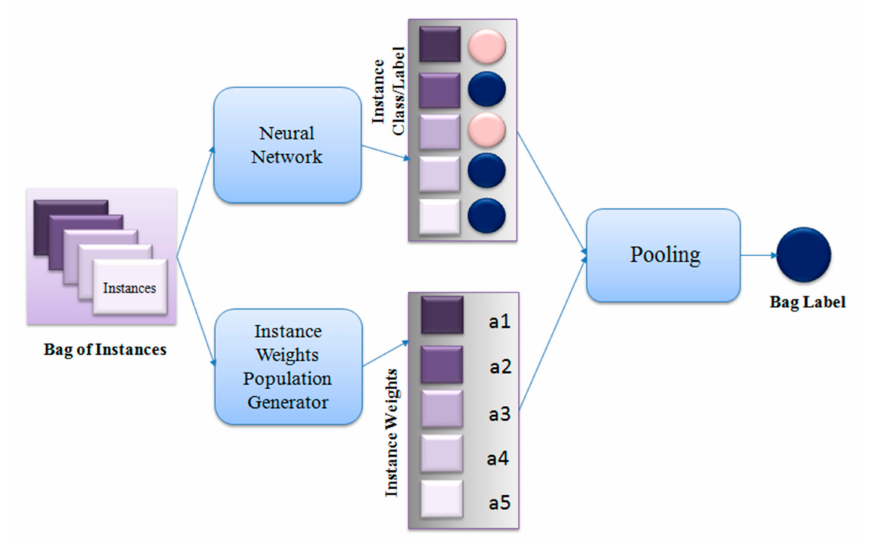
Figure 4. Evolutionary pooling